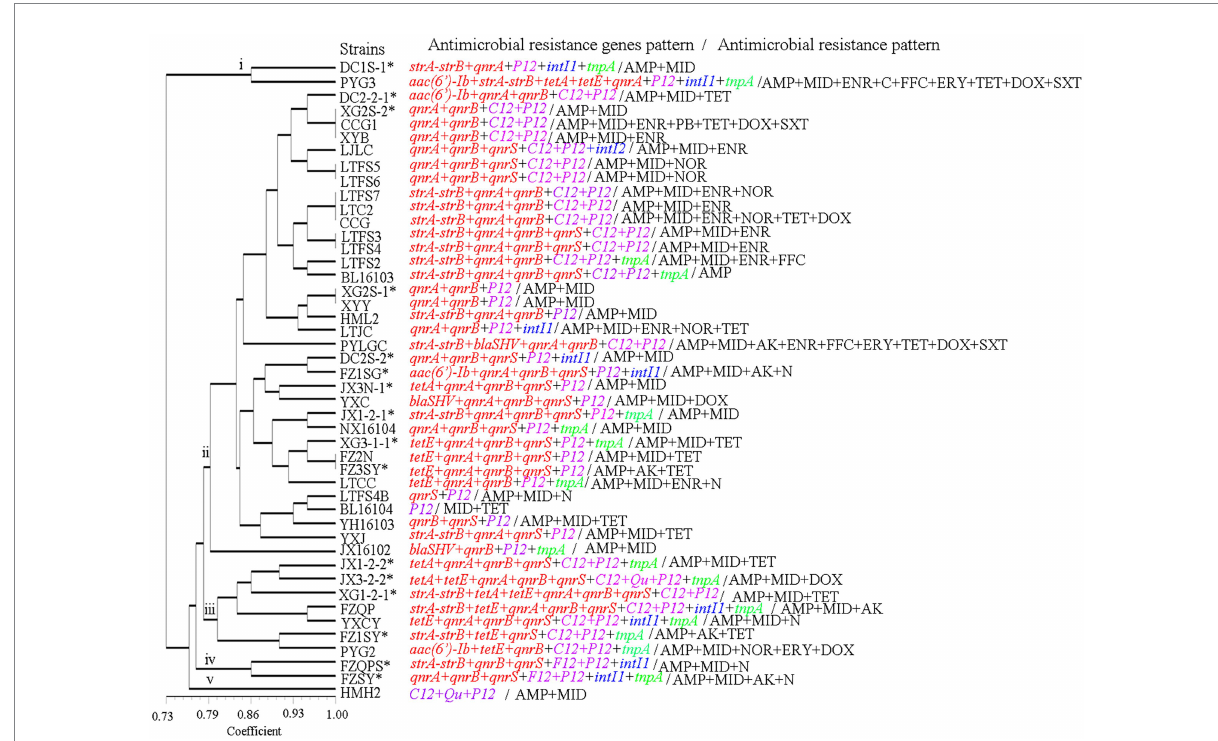
FIGURE 7 The antimicrobial resistance genes and antimicrobial resistance pattern of the A. veronii isolates used in this study. AK, amikacin; N, neomycin; GM, gentamycin; CTRX; ceftriaxone; AMP, ampicillin; NOR, norfloxacin; OFX, ofloxacin; ENR, enrofloxacin; C, chloramphenicol; FFC, florfenicol; MID, midecamycin; ERY, erythromycin; PB, polymyxin-B; TET, tetracycline; DOX, doxycycline; SXT, trimethoprim/sulfamethoxazole.